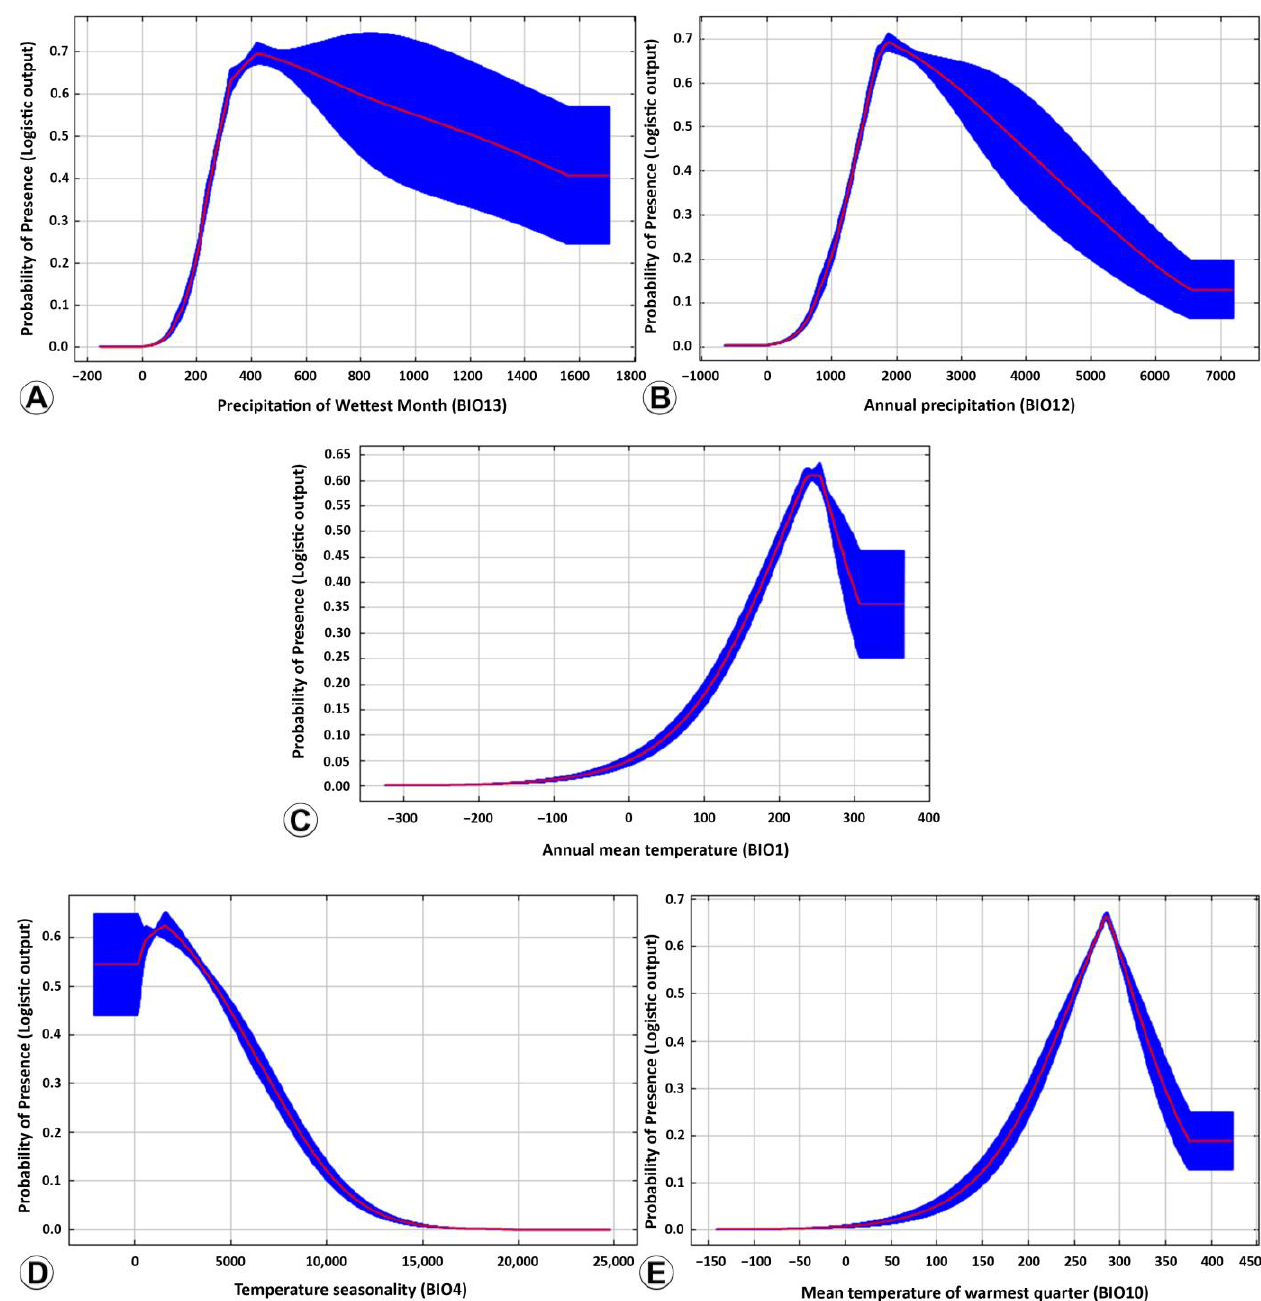
Figure 8. Response curves between bioclimatic variables and predicted suitability. ( A ) Precipitation of the wettest month (BIO13); ( B ) annual precipitation (BIO12); ( C ) annual mean temperature (BIO1); ( D ) temperature seasonality (BIO4); ( E ) mean temperature during the warmest quarter (BIO10). Table 5. Suitable range of bioclimatic variables for the potential distribution of Microplitis manilae .